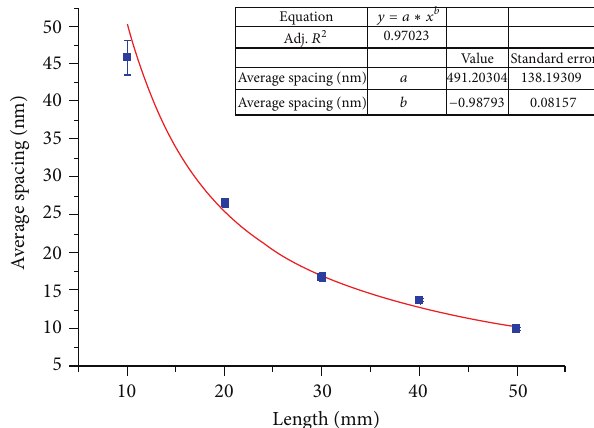
Figure 8: The relationship between various lengths and the spacing value between the